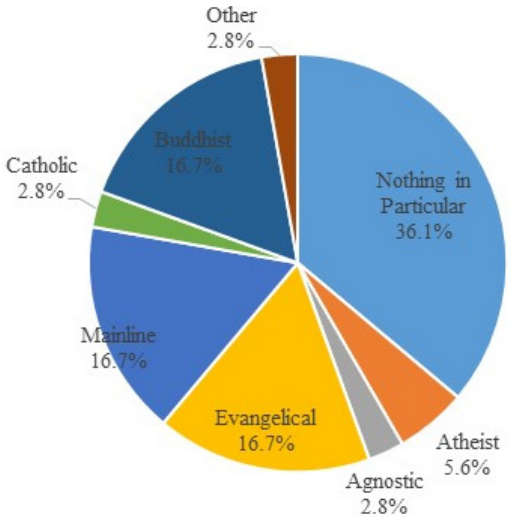
Figure 2. Religious Affiliation of Young Japanese